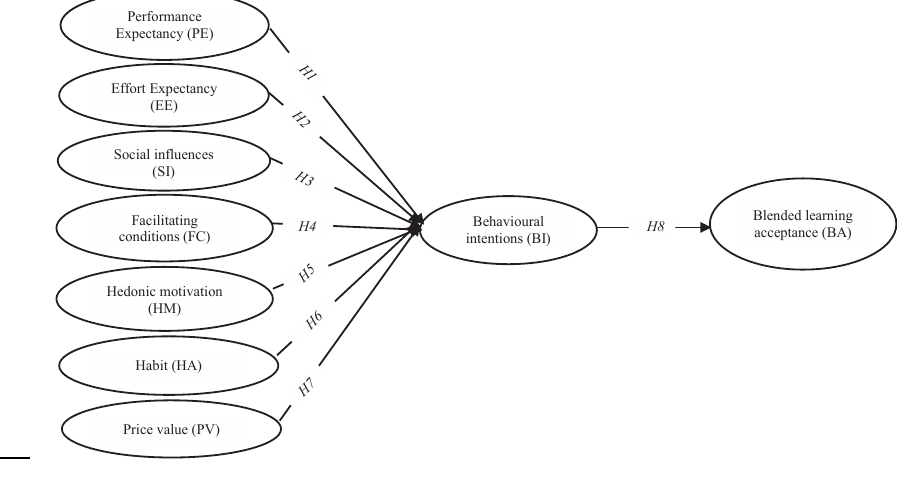
Figure 1. Research